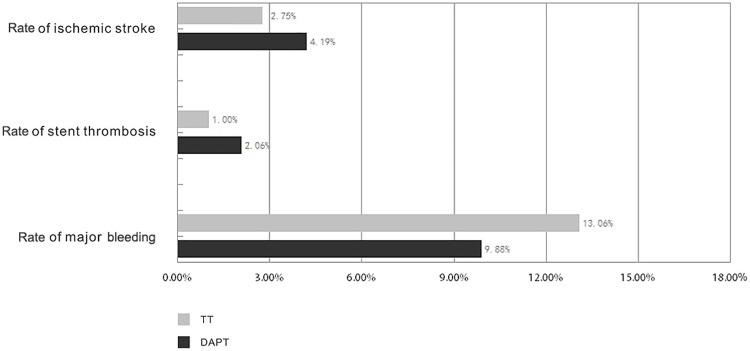
Rates of ischemic stroke, stent thrombosis and major bleeding at a follow up of median 1 year.